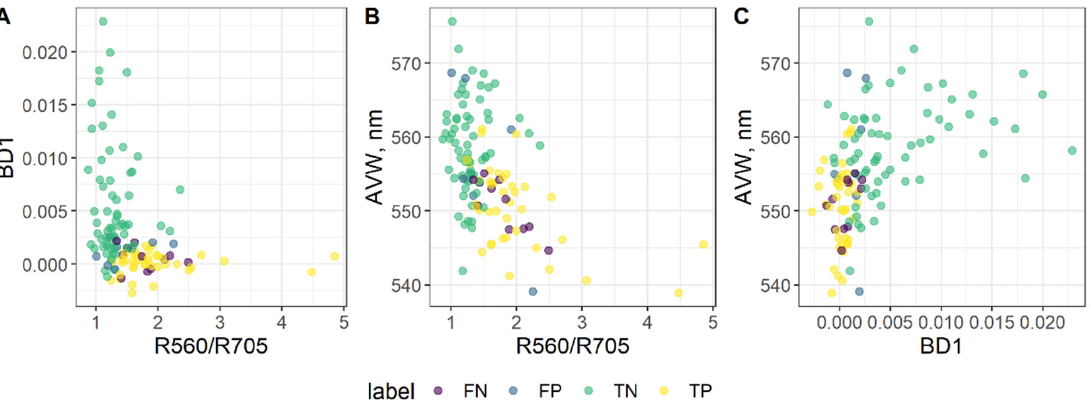
Figure 3. The scatterplots of features ( A ) R560/R705 and BD1, ( B ) R560/R705 and AVW, and ( C ) BD1 and AVW for false negatives (FN), false positives (FP), true negatives (TN), and true positives